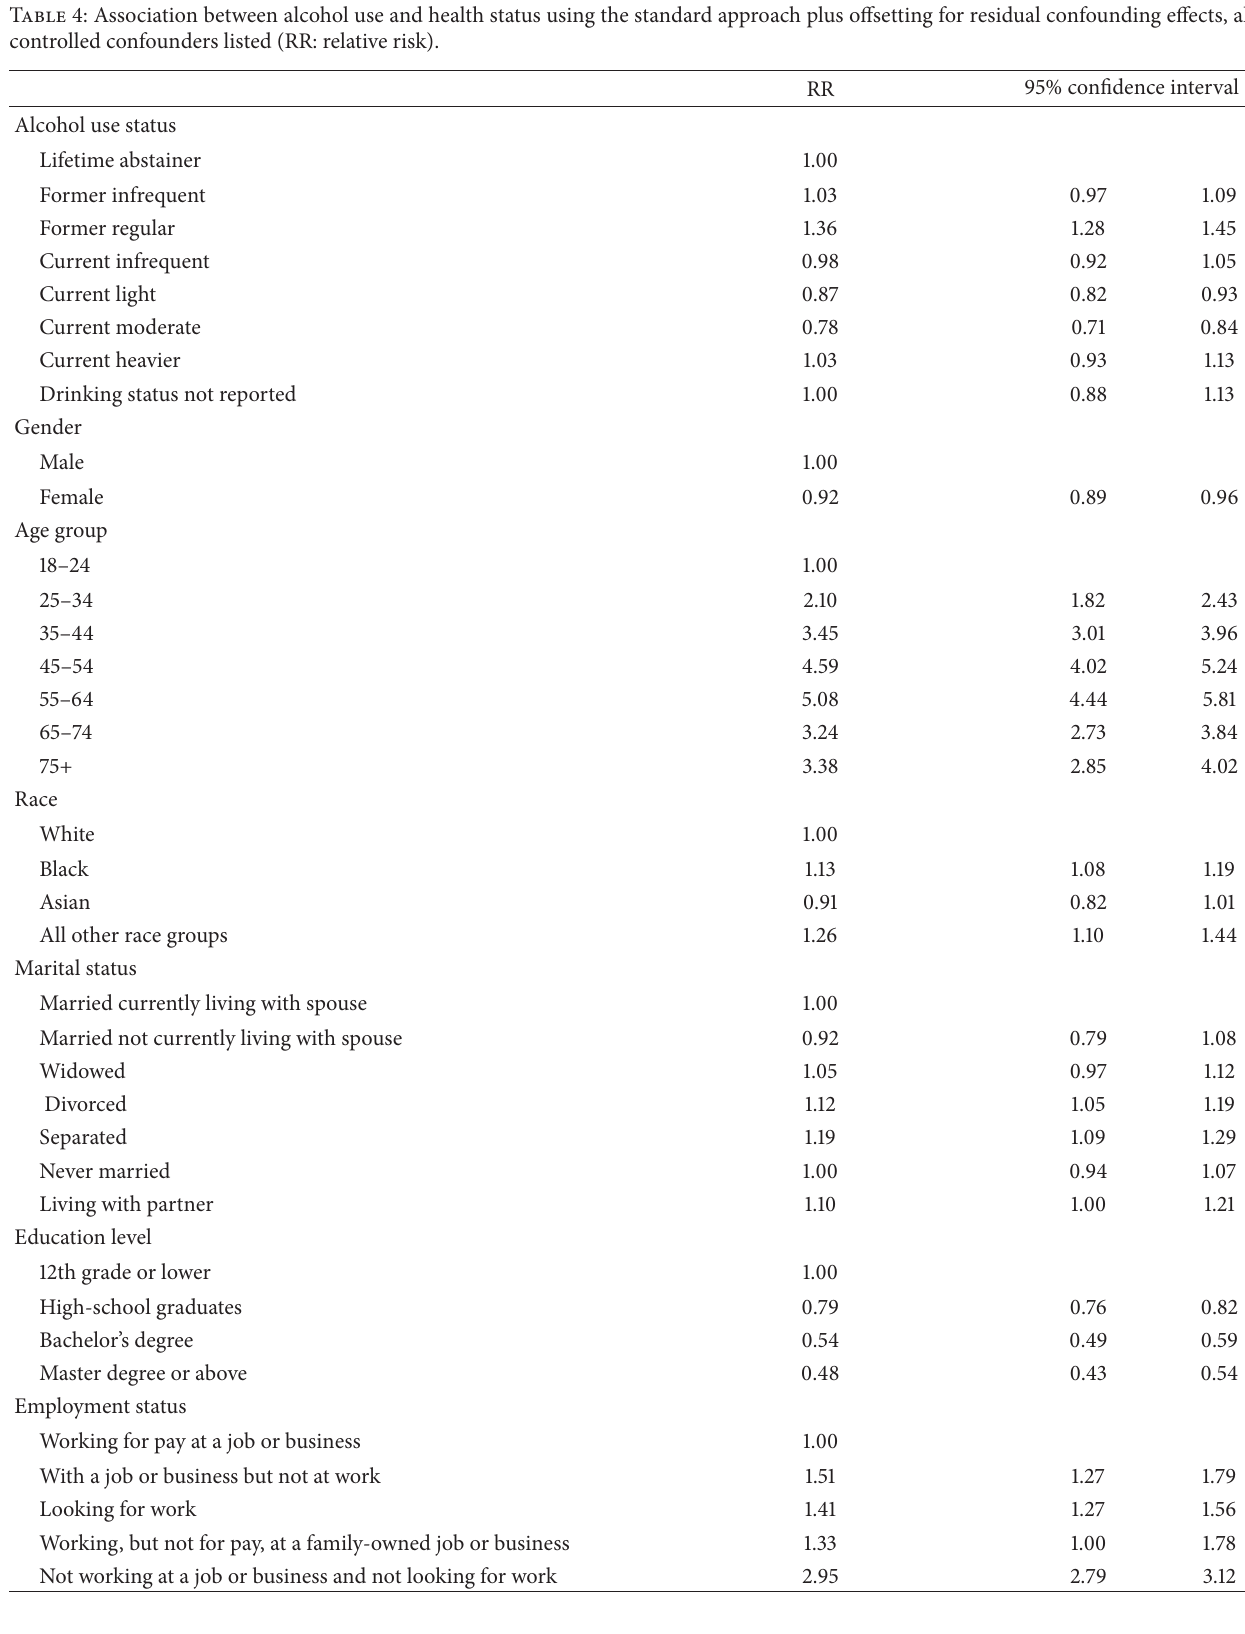
Table 4: Association between alcohol use and health status using the standard approach plus offsetting for residual confounding effects, all controlled confounders listed (RR: relative